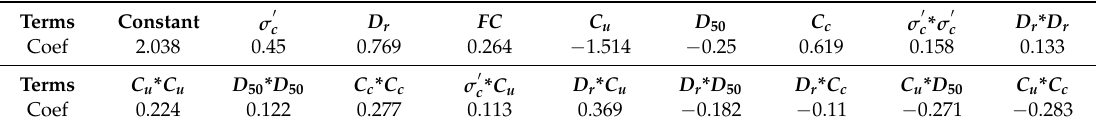
Table 9. RSM equation with the DOE of the CC design, based on the second ANN model (R 2 = 93.37%, R 2 [adjust] = 91.80%).